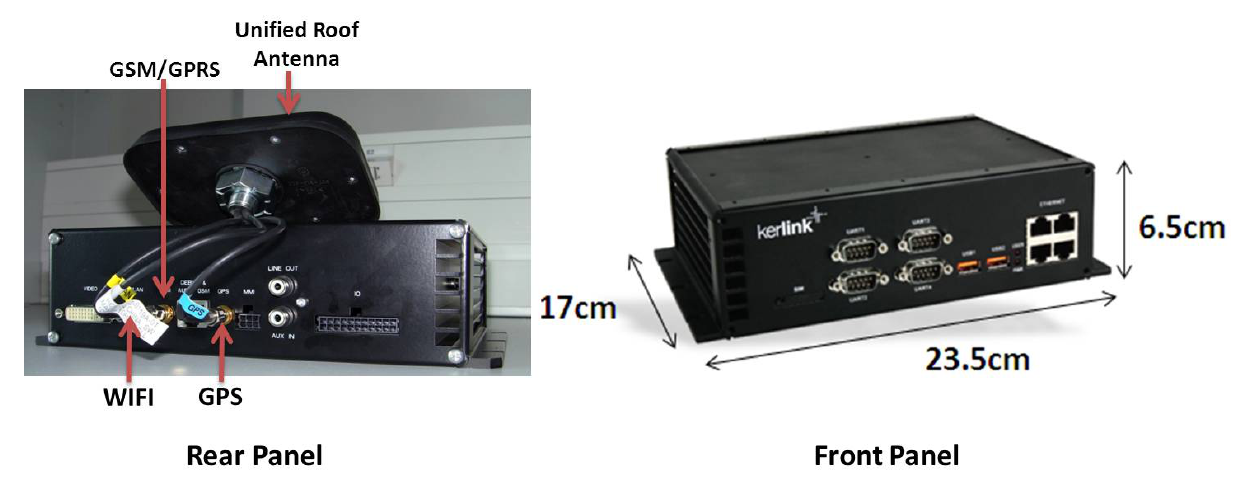
Figure 8. Kerlink Wirma Road